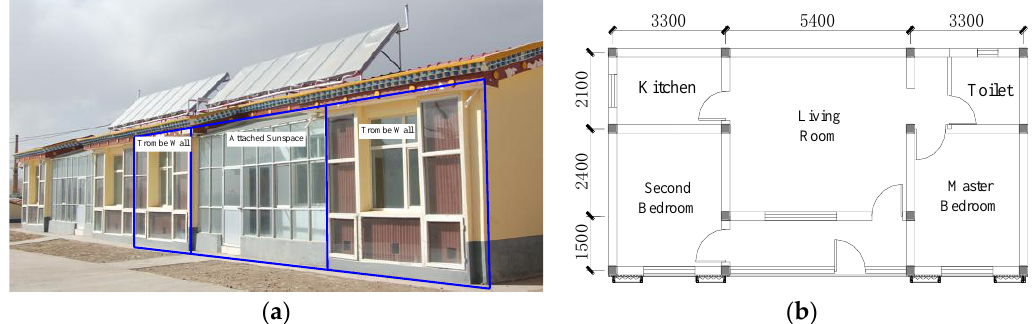
Figure 1. Building. ( a ) Photo of the exterior feature of the demonstration building; ( b ) plane layout and size of the demonstration building (unit: mm).